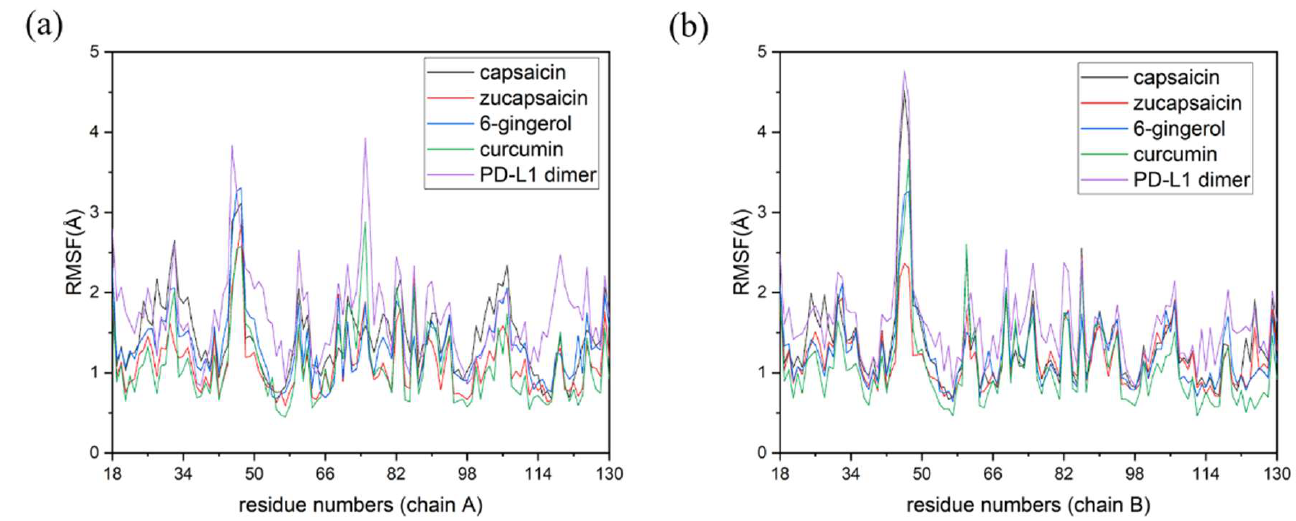
Figure 4. Root mean square fluctuation (RMSF) results of the MD simulations. ( a ) RMSF fluctuations of residues on (A)PD-L1. ( b ) RMSF fluctuations of residues on (B)PD-L1.